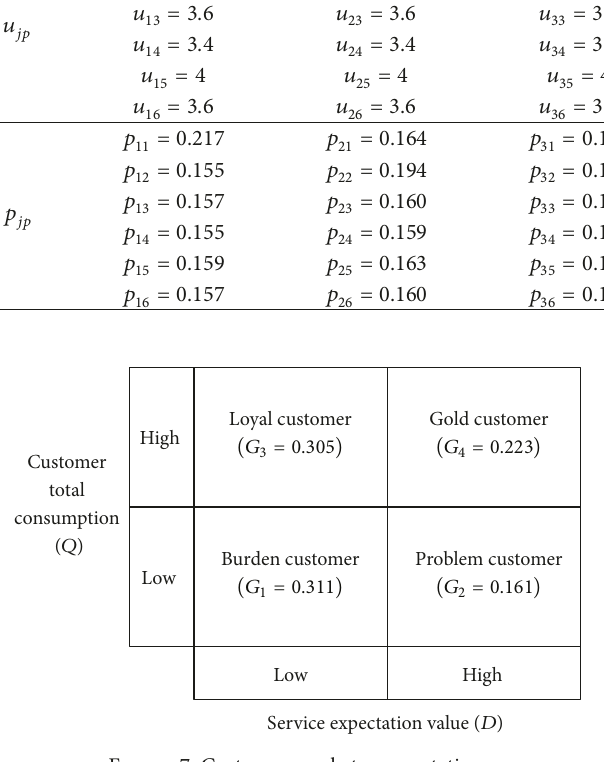
Figure 7: Customer market